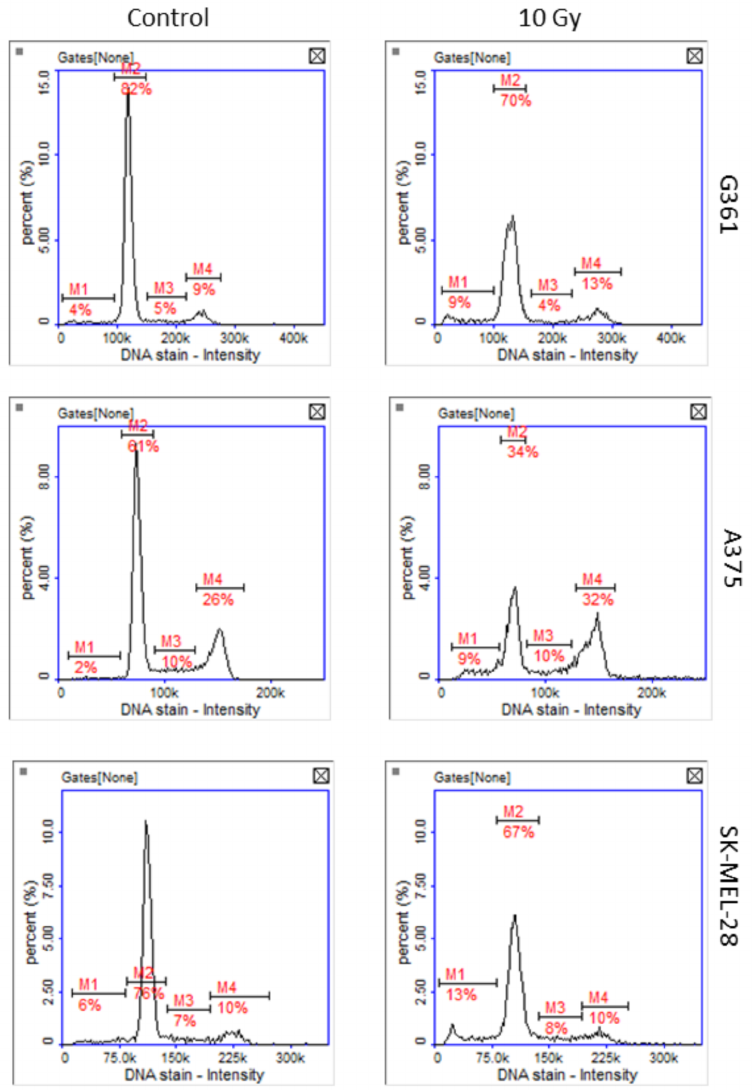
Figure 7. Representative histograms of cell cycle analysis obtained for G361, A375, and SK-MEL-28 melanoma cells 48 h after X-ray exposure (10 Gy, M1: subG1, M2: G1, M3: S, M4: G2/M